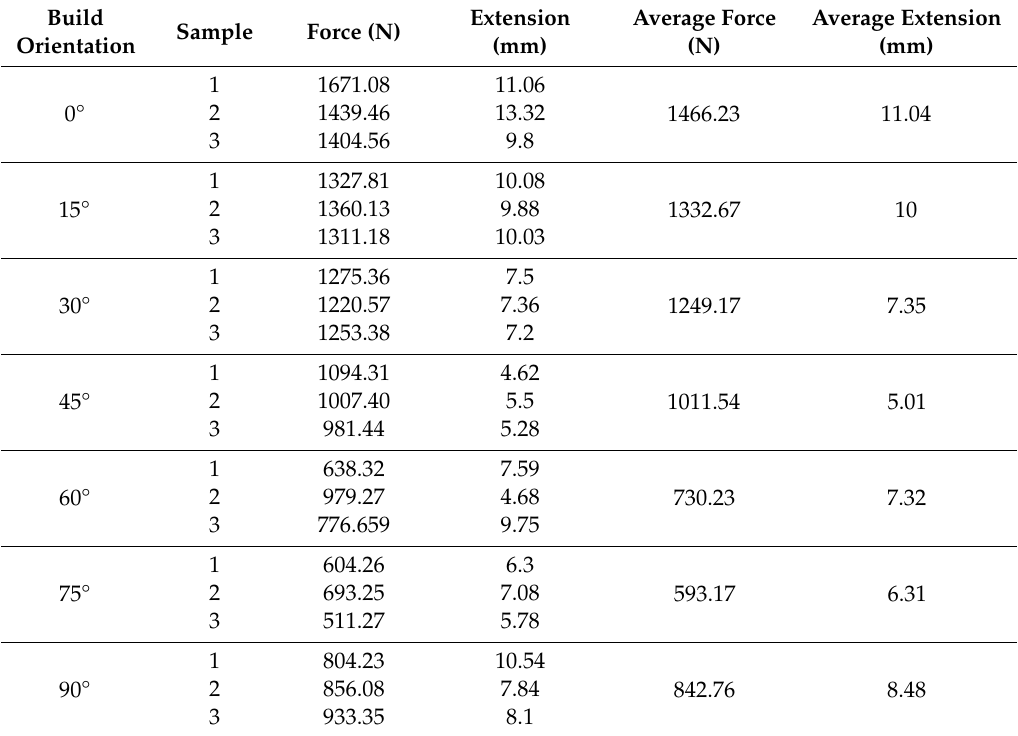
Table 6. Maximum tensile load for on-edge